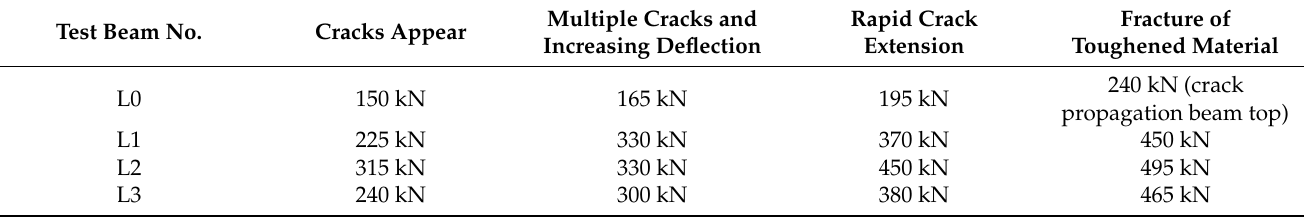
Table 5. Loading state load of each test beam.